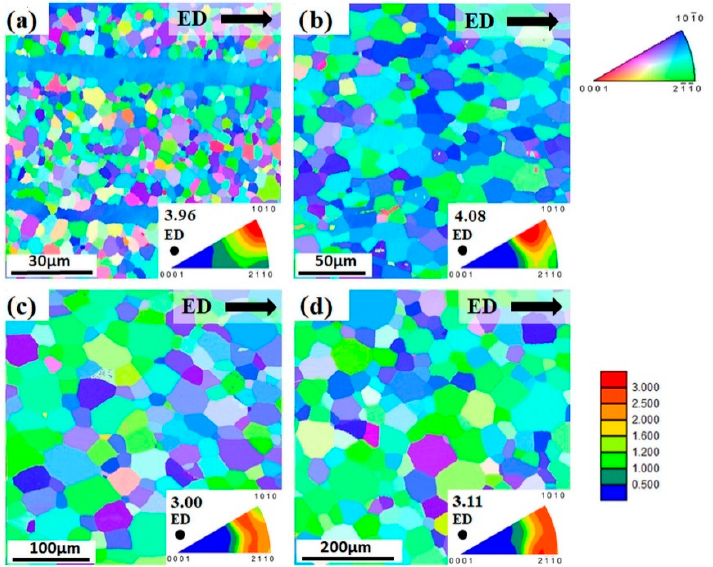
Figure 1. Initial microstructure of the extruded alloy: ( a ) ZX10-04, ( b ) ZX10-11, ( c ) ZX10-23, ( d ) ZX10-53 measured at longitudinal section (extrusion direction - ED is horizontal). Colour code used for orientation maps is represented along ED. Triangular inverse pole figure (IPF) in each subfigure represents texture of the alloy along ED (i.e., ED is perpendicular to IPF).